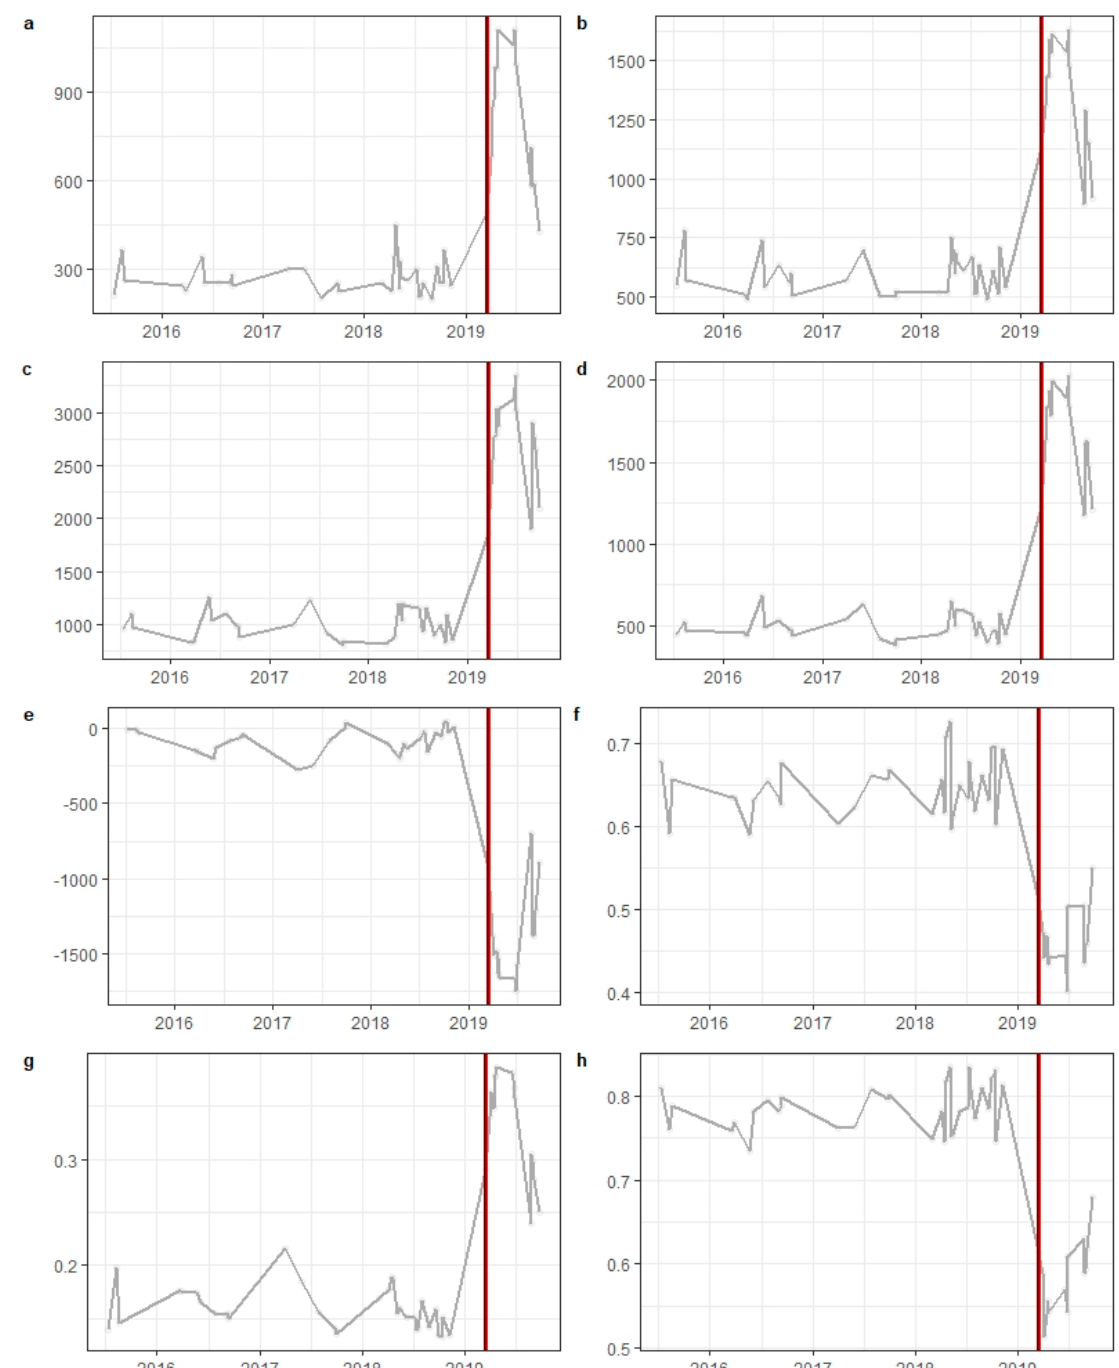
Figure 6. The example of spectral trajectories for a selected pixel, where all bands and indices provided correct change date: red vertical lines—detected break dates, black vertical line—real change date; ( a ) VIS R, ( b ) RE1, ( c ) SWIR1, ( d ) SWIR2, ( e ) TCW, ( f ) NDMI, ( g ) MSI, ( h ) NBR.